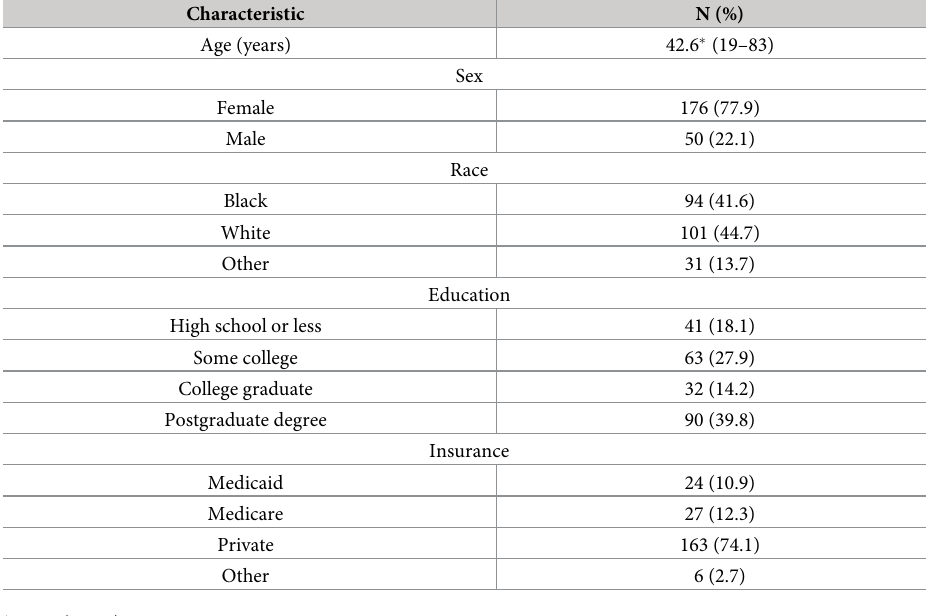
Table 1. Demographics of overall study population (N =